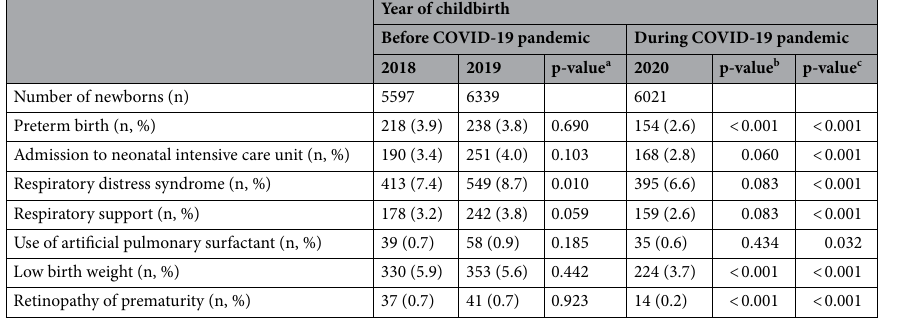
Table 2. Neonatal characteristics and complications among the 17,957 newborns that were born in the years 2018, 2019, and 2020. The denominator for the percentage is the number of newborns. P-values of Pearson’s chi-square test, a: between 2018 and 2019, b: between 2018 and 2020, and c: between 2019 and 2020 are shown. We used a P value of 0.0167 to indicate significance to correct for multiplicity.